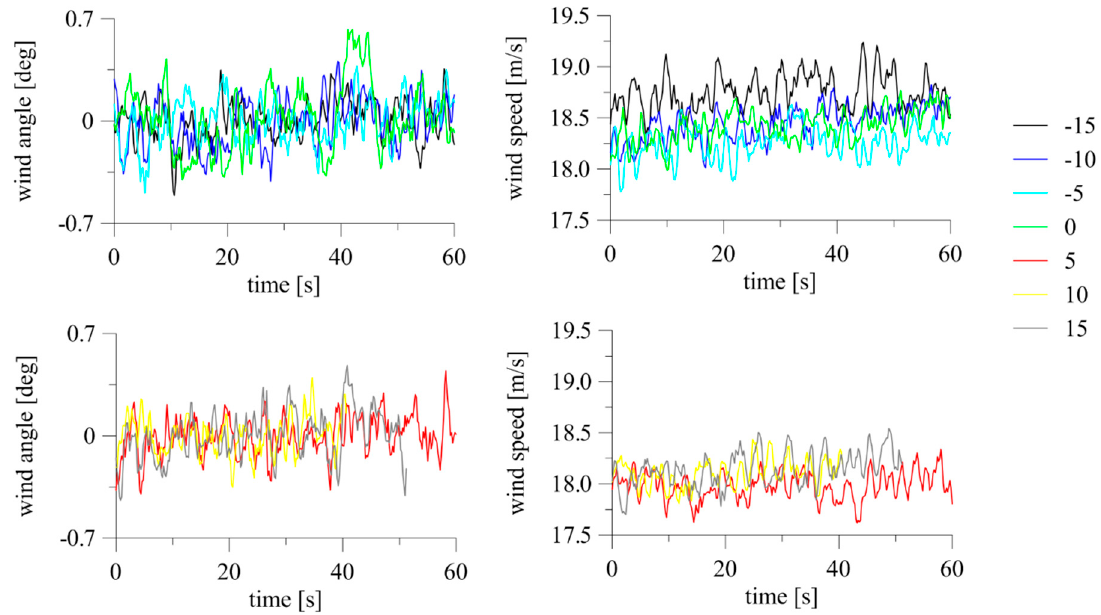
Figure 13. Fluctuations of wind angle and speed at changing β for 3D anemometer: α = 0°.